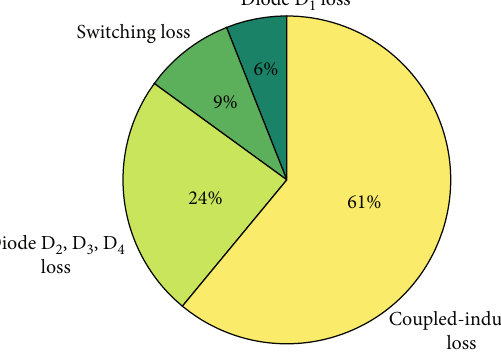
Table 7: Theoretical loss value.